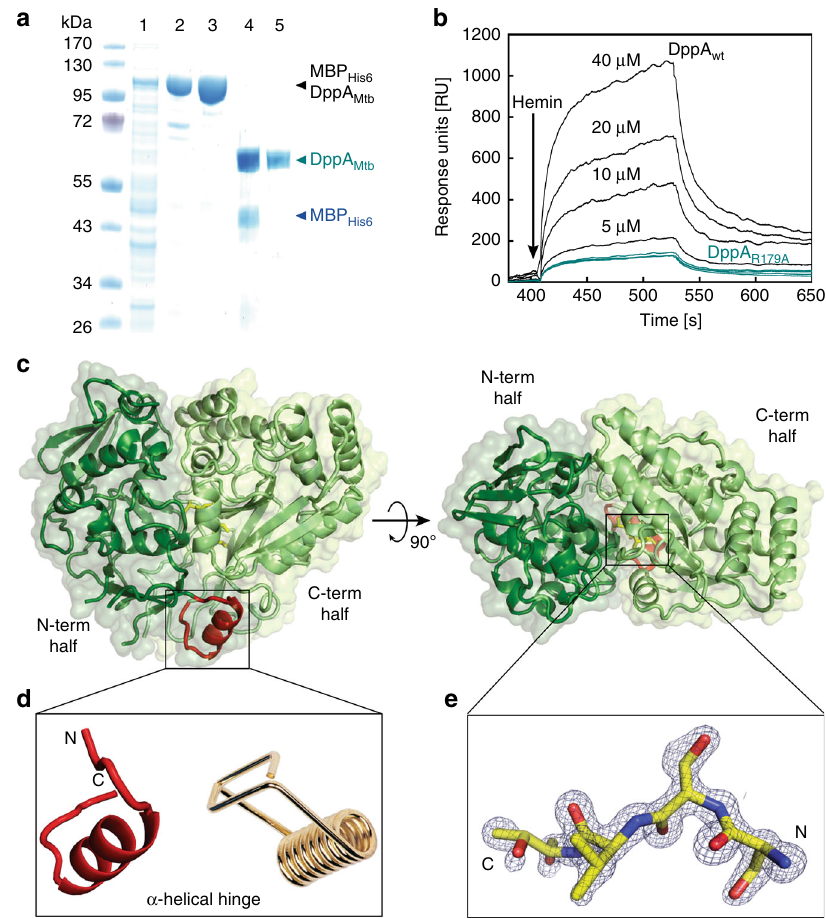
Fig. 4 Heme binding by M. tuberculosis DppA and its atomic structure. a Puri fi cation of DppA from E. coli . Lanes: (1) E. coli lysate containing mbp 6his -dppA expression vector, combined fractions after Ni(II)-af fi nity (2) and amylose af fi nity (3), (4) TEV cleavage of fusion protein and (5) puri fi ed DppA post TEV cleavage after Ni(II) recapture of MBP 6His . b Heme binding of wild-type DppA Mtb (black) and mutant DppA R179A (cyan) at varying heme concentrations determined by surface plasmon resonance (SPR) spectroscopy. Buffer controls do not show any signal for both proteins and are not visible because they overlap with the x -axis. The same heme concentrations were used for both proteins. Source data are provided in the Source Data fi le. c Ribbon diagram of Mtb DppA with N- and C-terminal halves of the protein color-coded in dark and light green, respectively. The ribbon diagram is overlaid to a semi- transparent solvent surface. d Magni fi ed view of DppA α -helical hinge (residues 250 – 266) colored in red, which bears a striking resemblance to a clothespin spring. e Magni fi ed view of DppA wt fi nal 2Fo − Fc electron density map calculated at 1.27 Å resolution and overlaid to the re fi ned model of DppA tetrapeptide (shown as sticks). The electron density is colored in blue and contoured at 1.7 σ above